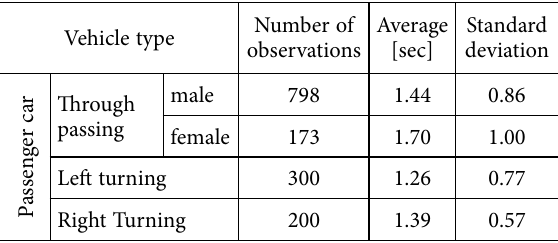
Table 4. Information about the start response time